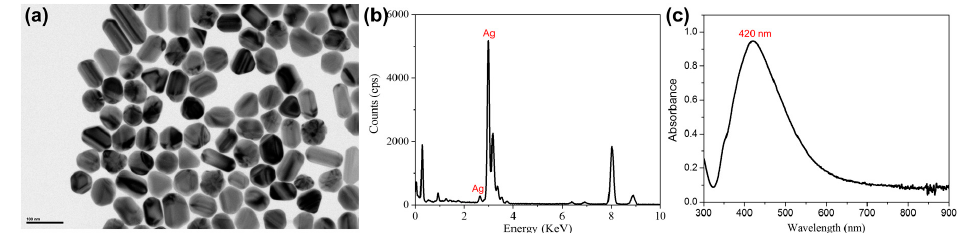
Figure 1. TEM image ( a ), energy-dispersive X-ray spectrum ( b ), and UV-Vis absorption spectrum ( c ) of the synthesized AgNPs. Scale bar in ( a ): 100 nm.